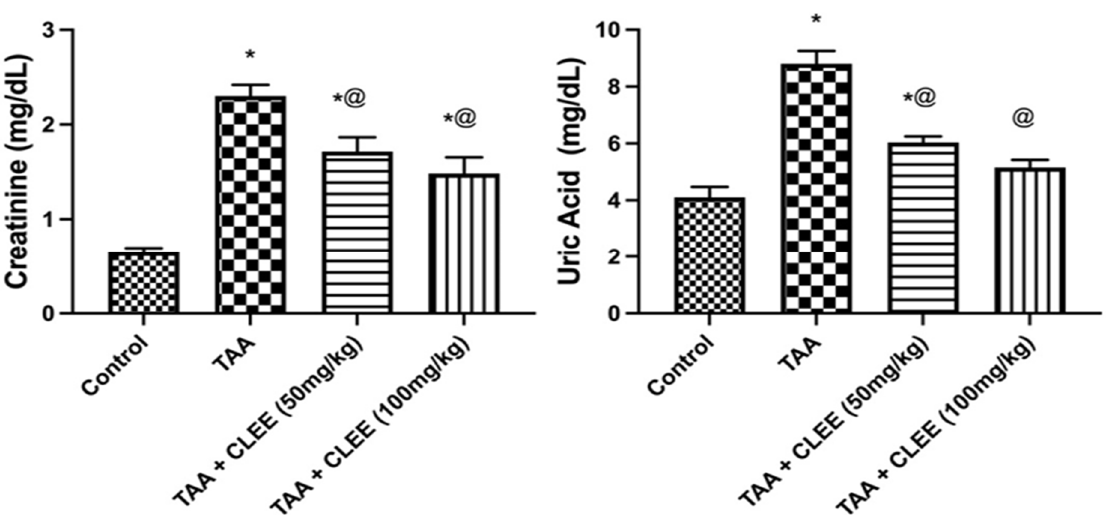
Figure 4. Effect of CLEE on kidney function parameters of rats intoxicated by TAA. Each value represents the mean of six animals ± SE. Statistical analysis was performed using one-way ANOVA followed by the Tukey-Kramer multiple comparisons test. (* vs control group, @ vs TAA group and # vs TAA + 50 mg /kg b.w. CLEE group) at p < 0.05.